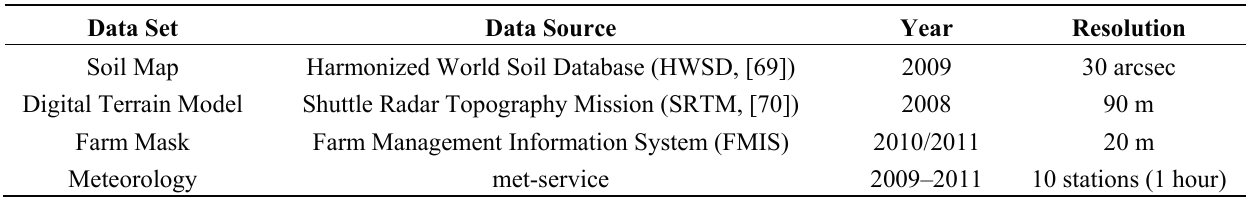
Table 4. Basic input parameters used for the setup of the PROMET model for the test site in Northern Germany at a spatial resolution of 20 m.